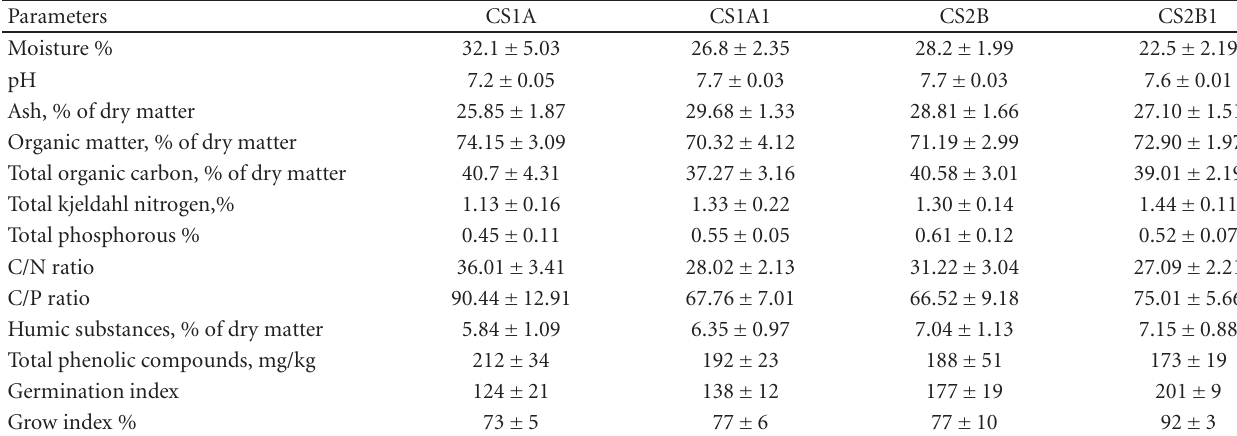
Table 5: Physicochemical characteristics of mature compost